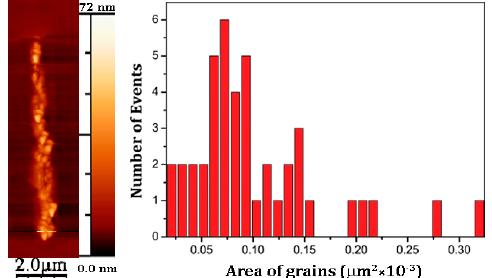
Figure 3. Topography at high magnification after application of − 20 V applied to the surface during scanning of the area 0.2 × 2 µ m 2 ( left ) and grain size distribution of the crystallized BaTiO 3 film after poling ( right